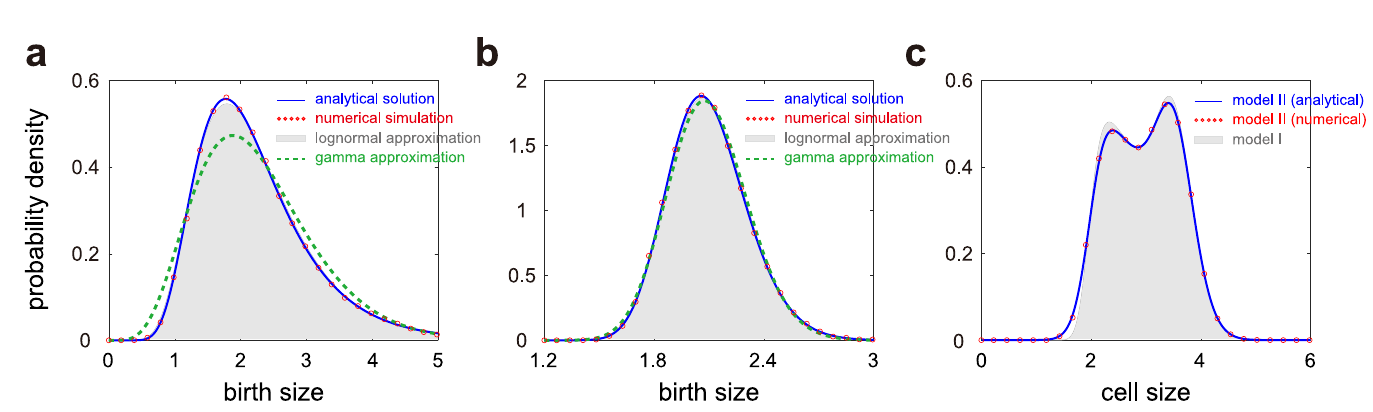
Fig 4. Further properties of the birth size and cell size distributions. A : Comparison of the birth size distribution (blue curve and red circles) with its log-normal (solid grey region) and gamma (dashed green curve) approximations when N and α are small. The blue curve shows the analytical distribution obtained by taking the inverse Laplace transform of Eq (13) and the red circles show the distribution obtained from stochastic simulations. B : Same as A but when N and α are large. In A, B, the parameters are chosen as r 0 = 0.6, r 1 = 0.1, g 0 = 0.01, g 1 = 4 g 0 , p = 0.5. The parameters N and α are chosen as N = 10, α = 0.5 in A and N = 30, α = 2 in B. C : Comparison between the cell size distributions for the model with deterministic partitioning (solid grey region) and the model with stochastic partitioning (blue curve and red circles). The blue curve shows the analytical distribution obtained by taking the inverse Laplace transform of Eq (15) and the red circles show the simulated distribution. The parameters are chosen as N = 30, r 0 = 0.6, r 1 = 0.1, g 0 = 0.01, g 1 = 4 g 0 , α = 2, p = 0.5. For the model with stochastic partitioning, the parameter ν is chosen as ν = 200. In A-C, the parameters a , M 0 , M 1 are chosen so that the mean cell size h V i = 3 for the model with deterministic partitioning.